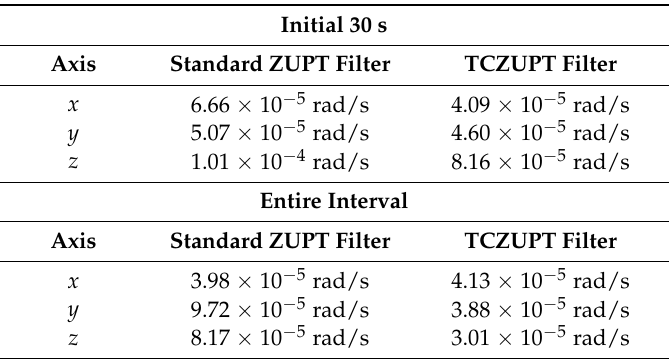
Figure 16. Gyro output bias (residual error of 15 degree/h, z -axis). Table 7. Root Mean Squared Error (residual error of 15